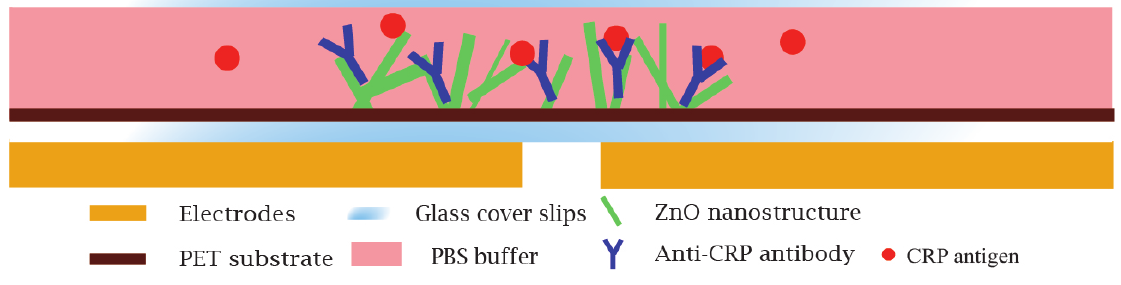
Figure 1. The cross sectional illustration of